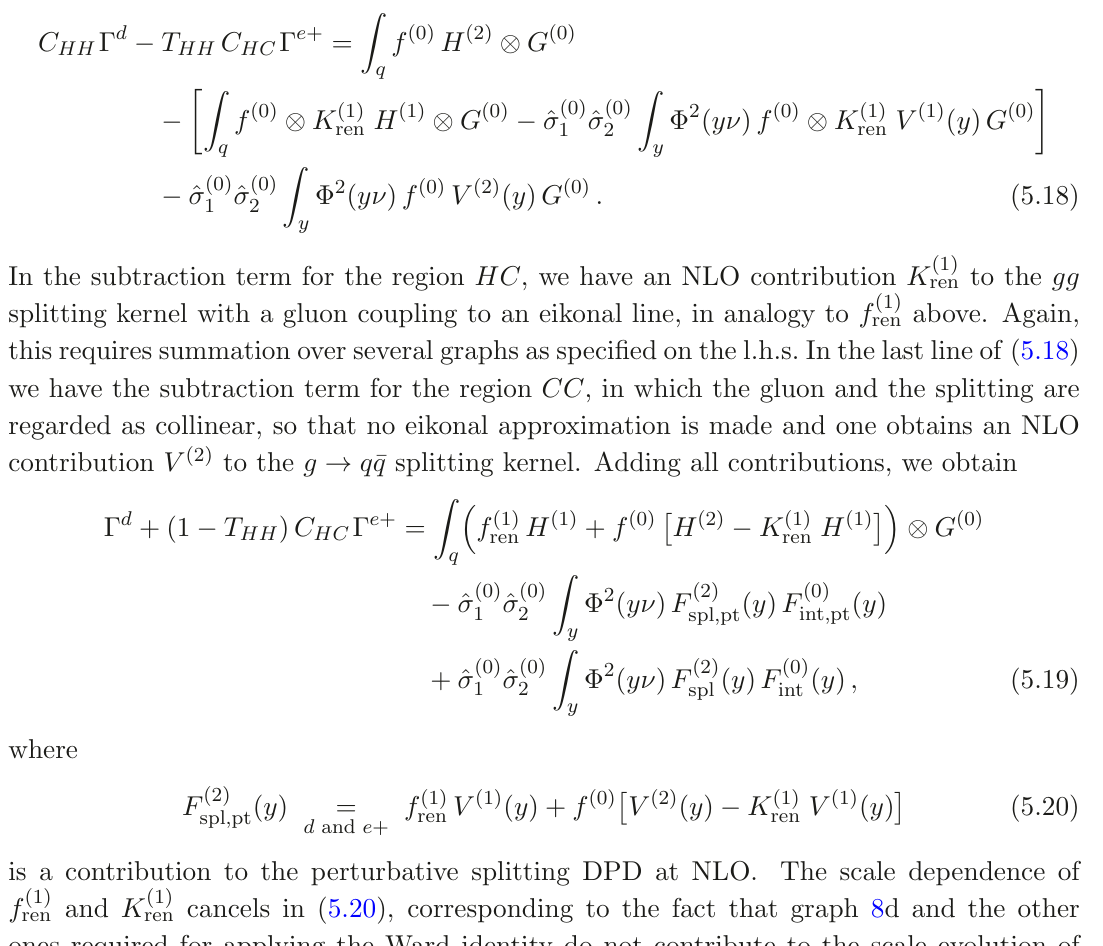
Figure 9 . Graphical representation of applying the Grammer-Yennie approximation and a Ward identity to the sum of four graphs. The three other graphs required are graph e in figure 8, and the analogues to graphs d and e in which the gluon couples to the quark line at the very right. It is understood that the g q ¯ q splitting is hard, whereas the gluons are collinear left moving. → where Γ e + denotes the sum of graph e and of two graphs analogous to graphs d and e, with the gluon coupling to the rightmost quark line. f (1) ren is an NLO contribution to the gluon density, involving a gluon coupling to an eikonal line. The integral over the gluon transverse momentum diverges in the ultraviolet and hence requires renormalisation. For the HH region we